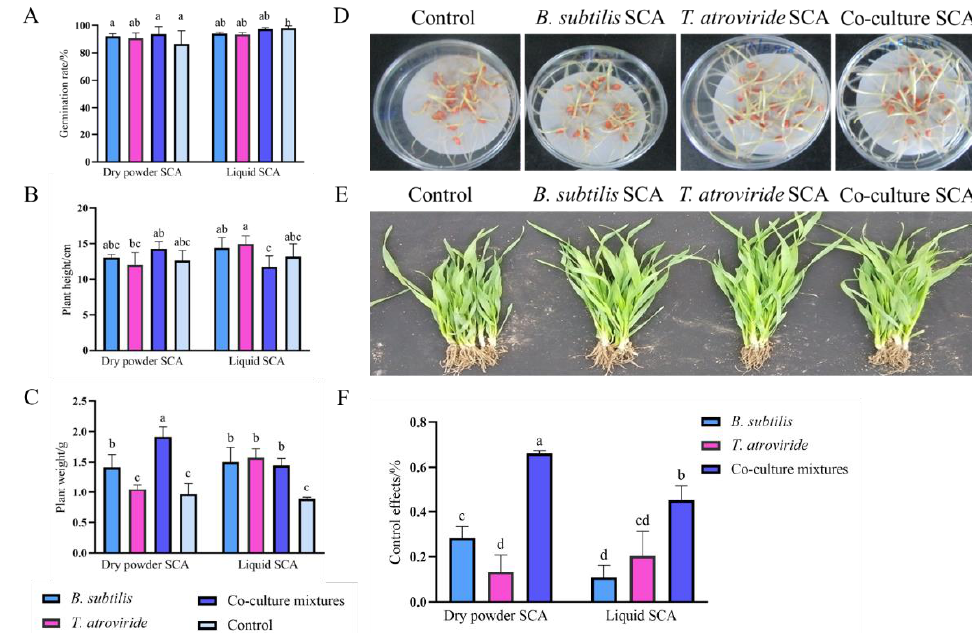
Figure 5. Effects of co-culture and axenic culture seed-coating agent (SCA) on: ( A ) the germination rate of wheat seeds; ( B ) plant height of wheat; ( C ) raw weight of wheat seedlings; ( D ) dry powder seed-coating agent treated wheat seeds; ( E ) dry powder seed-coating agent-treated wheat seedling. ( F ) Control effects of T. atroviride , B. subtilis , and co-culture mixtures against F. graminearum . Wheat seeds were treated with dry powder and a liquid seed-coating agent in this study. The dry powder seed-coating agent has been demonstrated to be an efficient SCA. a, b, c, d represent significant differences between the axenic and co-culture treatments ( p < 0.05).